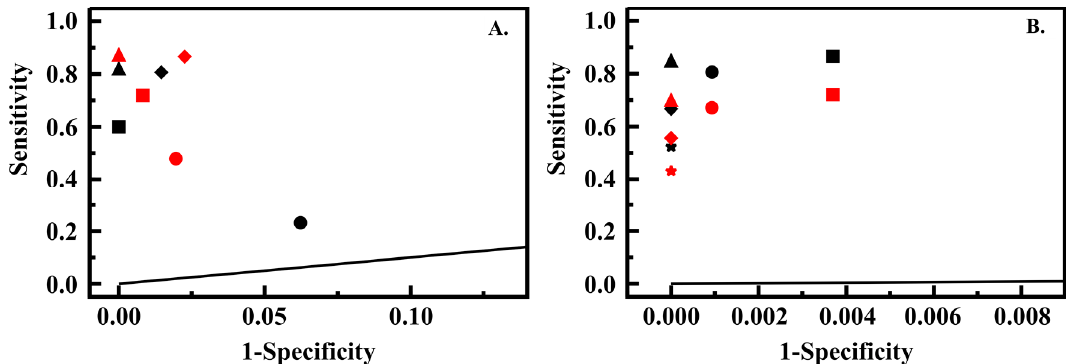
Figure 5. ( A ) ROC analysis for PT5 data sets collected at 100 (circle), 200 (square), 400 (triangle) and 500 ms (diamond) integration when evaluated using the single seat (s1, black) and dual seat (s2, red) slope based algorithms; ( B ) ROC analysis of the 500 ms PT5 data set using 0.16 (black) and 0.05 (red) ppm detection thresholds with variations of the slope based algorithm: one seat, 0.45°, circle; two seat, 0.45°, square; three seat, 0.45°, triangle; one seat, 1.45°, diamond; one seat, 2.45°, star.